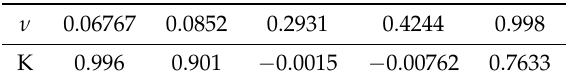
Table 1. Results of the 0–1 test for the fractional order map (6) with different fractional order